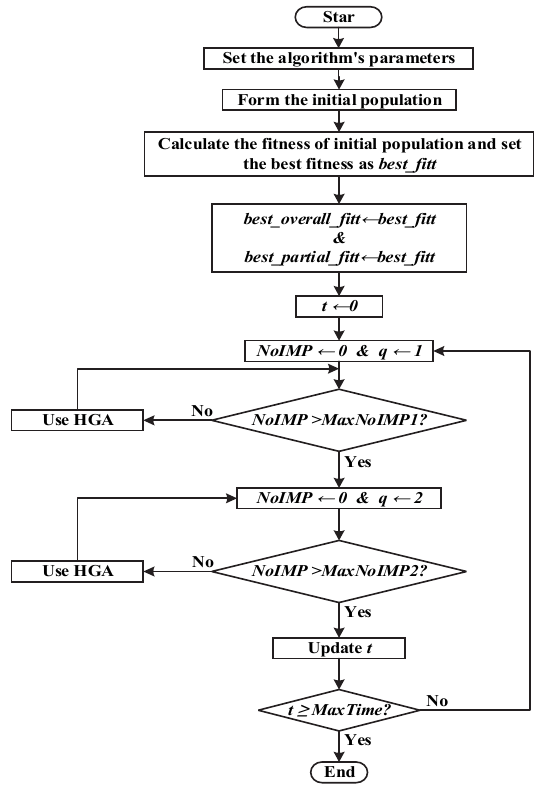
Fig. 4. Flowchart of the bi-level HGA Star